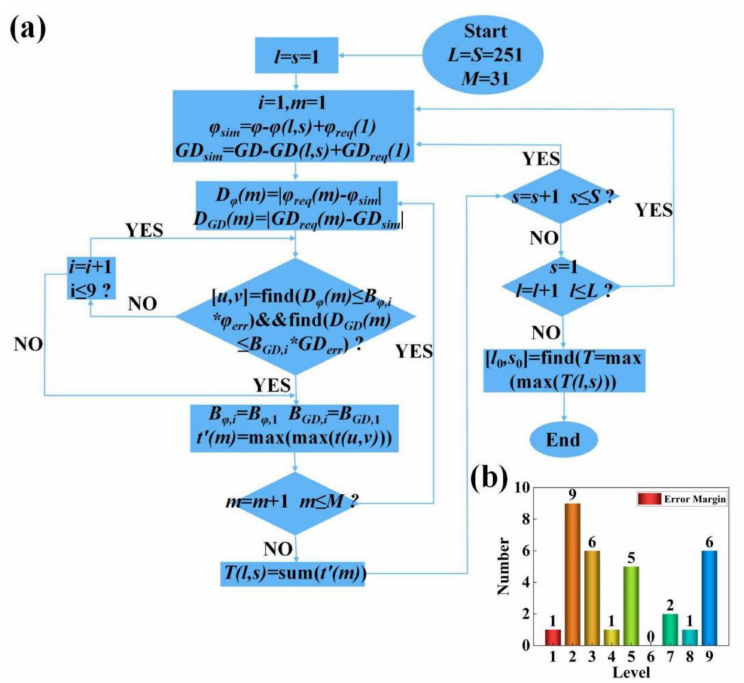
Figure 3. ( a ) Algorithmic flowchart of the nanorod search procedure. ( b ) Error margin of the 31 nanorods selected using the search